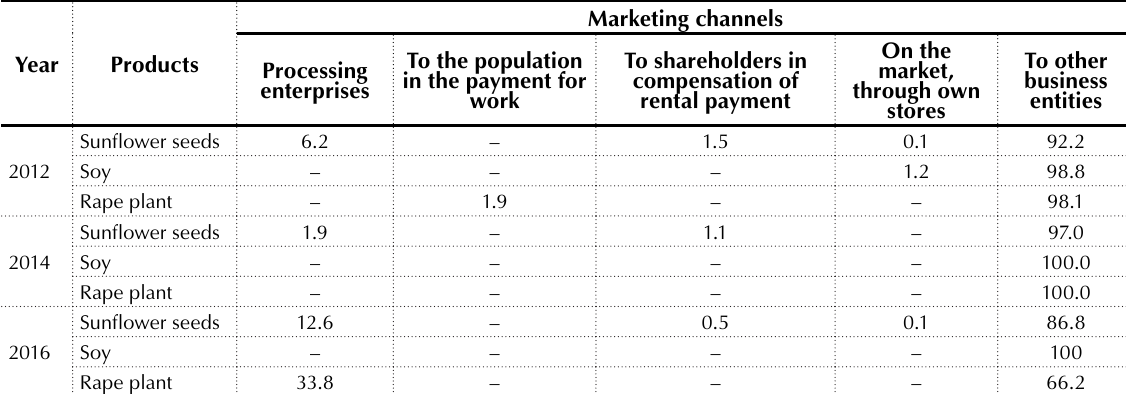
Table 5. The structure of oilseed crops sales channels by agricultural enterprises of Khrystynivka district, Cherkasy